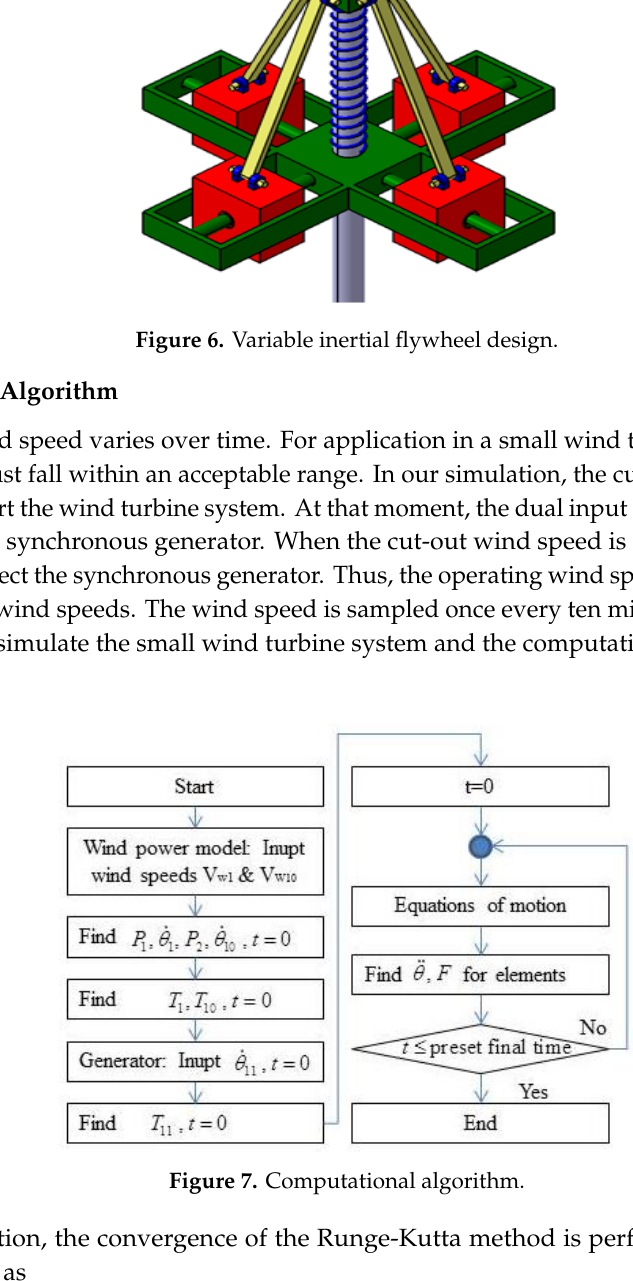
Figure 8. Steps form for the wind speed simulation. Table 1. Gear number. Terms